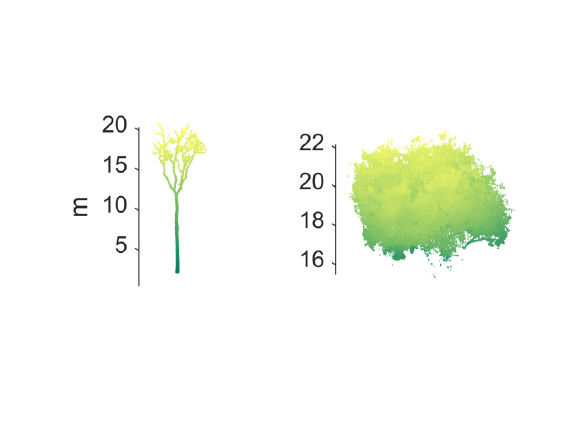
Figure 6. A crown subset (i.e., 16 - 20 m) of the Erytrophleum fordii . Branches and leaves heavily interact.